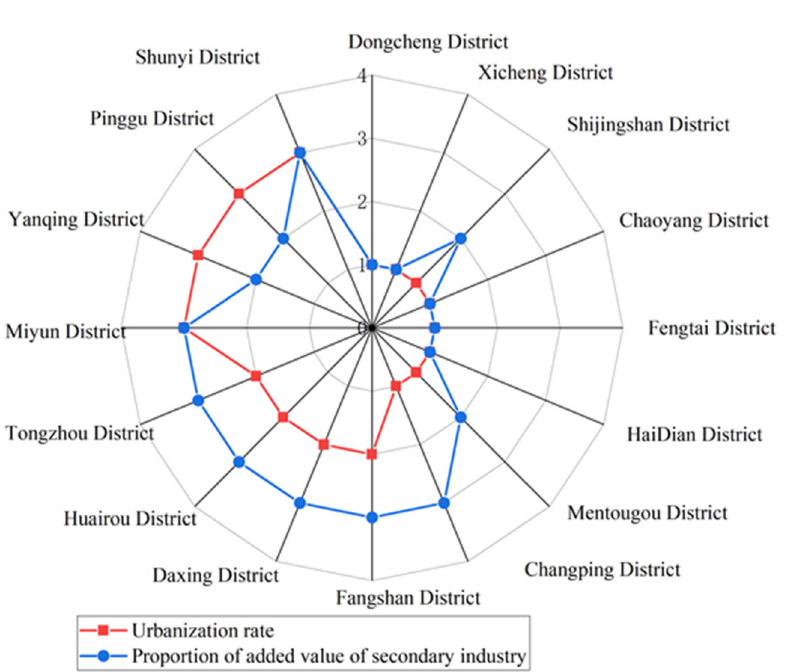
Figure 6. Spatial analysis chart of the proportion of added value between urbanization and secondary industry in Beijing.